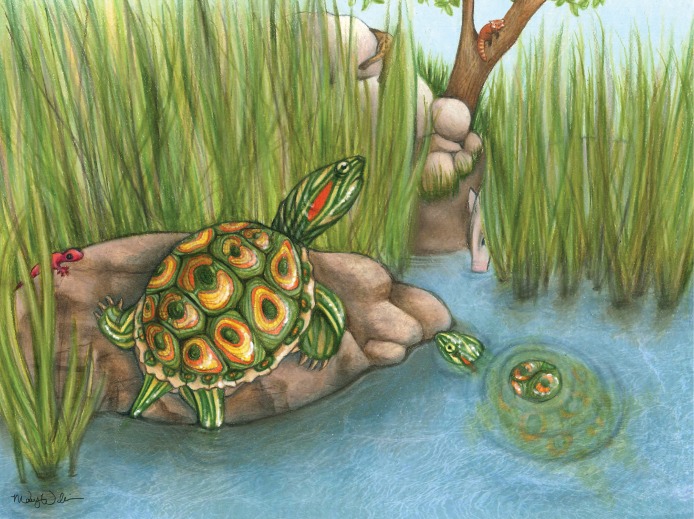
Life reconstruction of Trachemys haugrudi during the late Hemphillian at the Gray Fossil Site in eastern Tennessee.Several taxa that would have lived alongside T. haugrudi are also shown, including Caudata indeterminate, Tapirus polkensis, cf. Machairodus sp., and Pristinailurus bristoli (Wallace & Wang, 2004; Boardman & Schubert, 2011b; Schubert, 2011; Jasinski, 2013a). Artwork by Mary P. Williams, with permission.